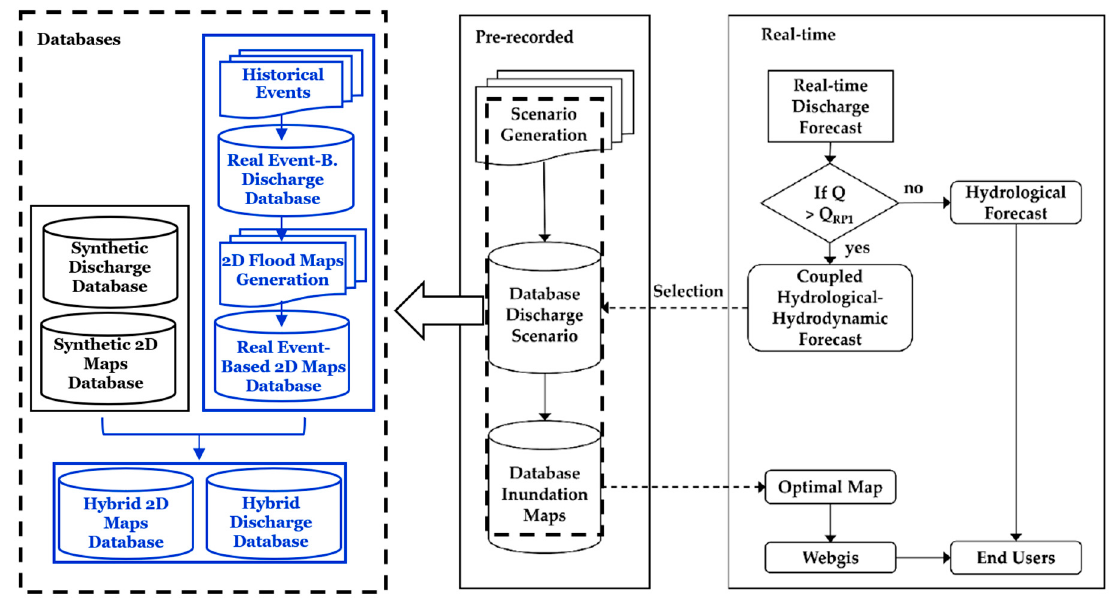
Figure 1. Framework of the offline flood inundation forecast including the pre-recorded and real-time extended from Bhola et al. (2018). The contributions presented in this paper are marked in blue.